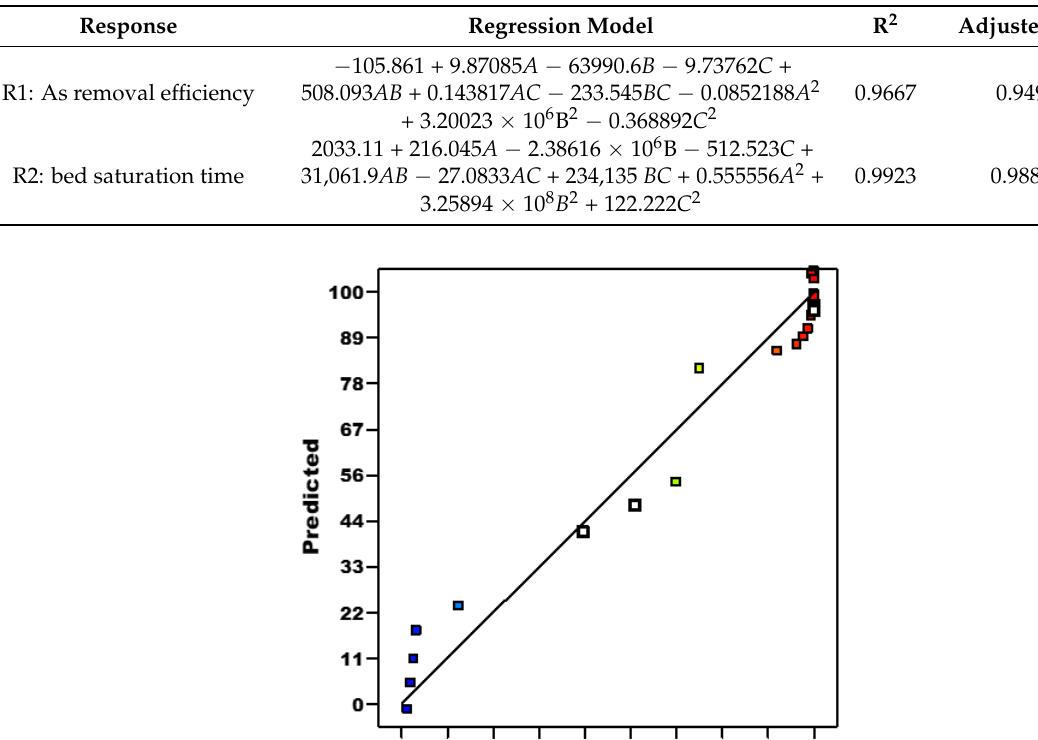
Table 6. Regression model equations for R1 and R2 and values of R 2 .